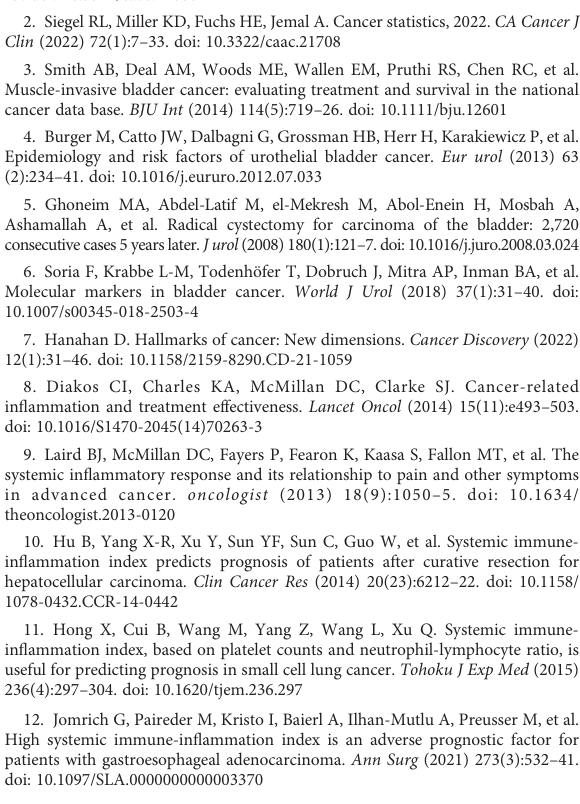
SUPPLEMENTARY FIGURE 2 (A) Subgroup analyses for overall survival (OS) based on SII levels. Each strati fi cation adjusted for all the factors including age, gender, pT stage, pN stage, adjuvant therapy, PSM, LVI, except for strati fi cation factor itself. (B) Subgroup analyses for recurrence-free survival (RFS) based on SII levels. Each strati fi cation adjusted for all the factors including age, gender, adjuvant therapy, pT, pN, PSM, PNI, except for strati fi cation factor itself. SII, systemic immune-in fl ammation index; BMI, body mass index; HR: hazards ratio; HBP: high blood pressure. DM: diabetes mellitus; PSM: positive surgical margins PNI: peripheral nerve invasion; LVI: lymphovascular invasion; CI, con fi dence